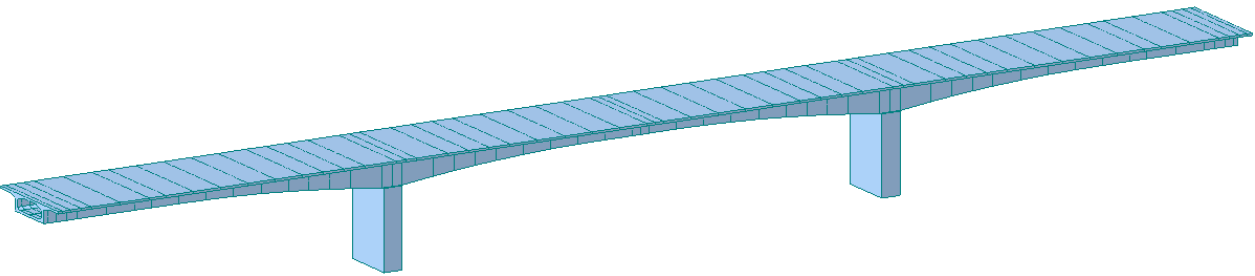
Figure 9. Numerical model of Huangsha Harbor Bridge at a construction stage.